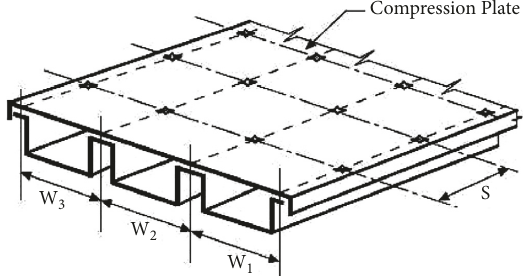
Figure 1: Composite roof cross section.